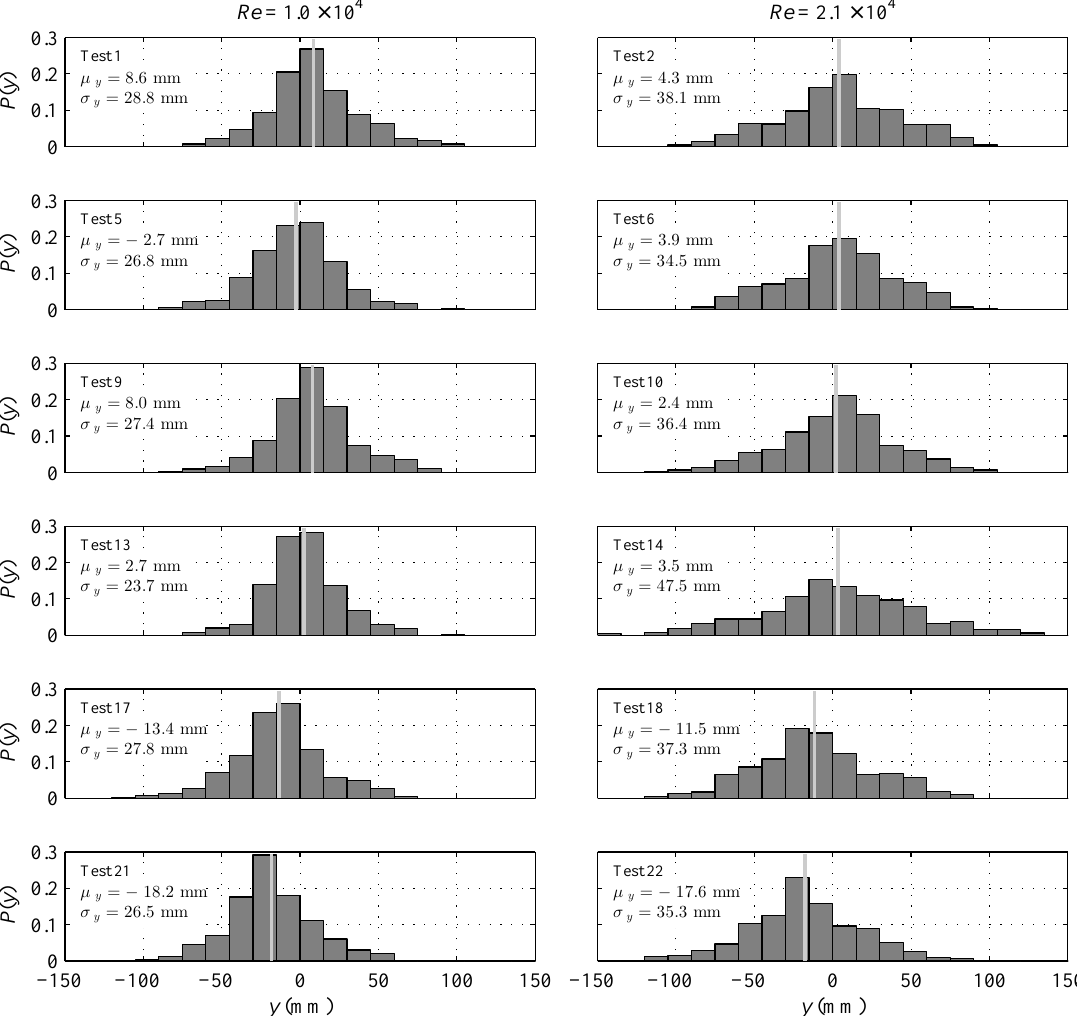
Figure 9. Histograms showing lateral distributions of beads at x = − 2 D for tests with lateral release location of y = 0. The distribution mean is shown with a vertical grey line for each